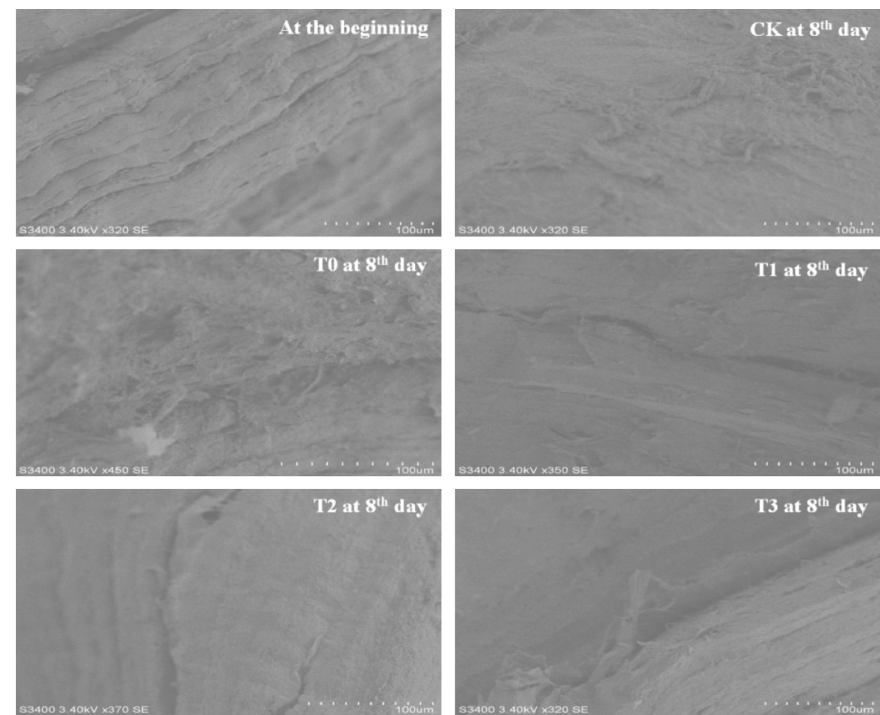
Figure 3: SEM images of crayfish under different treatments during storage. (a) At the beginning. (b) CK at 8 th day. (c) T 0 at 8 th day. (d) T 1 at 8 th day. (e) T 2 at 8 th day. (f) T 3 at 8 th